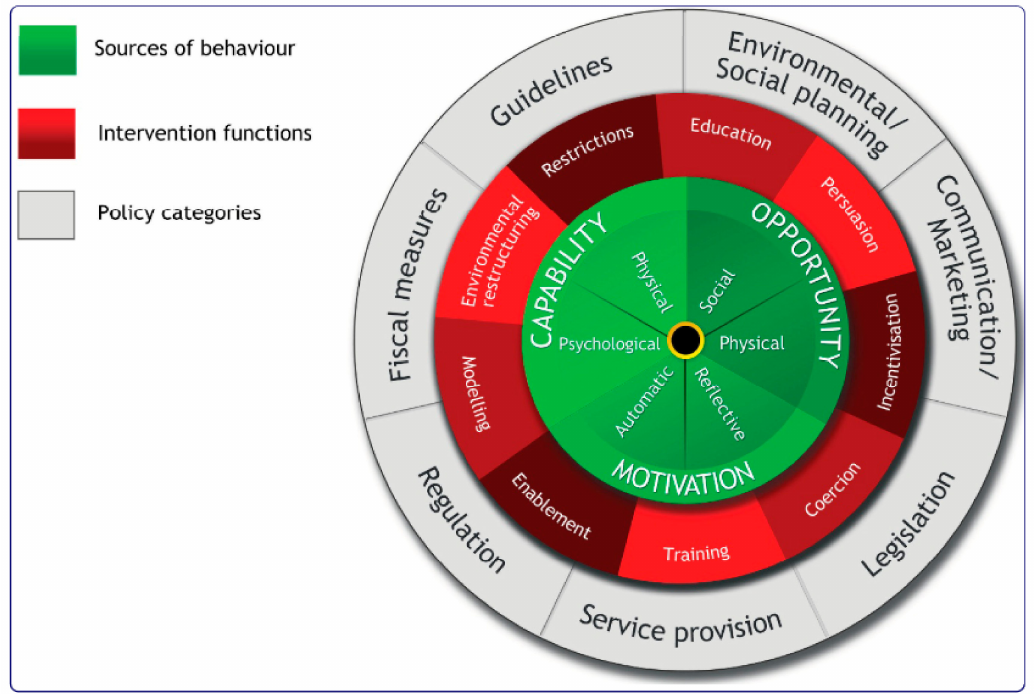
Figure 1. The Behaviour Change Wheel (Michie et al., 2011)